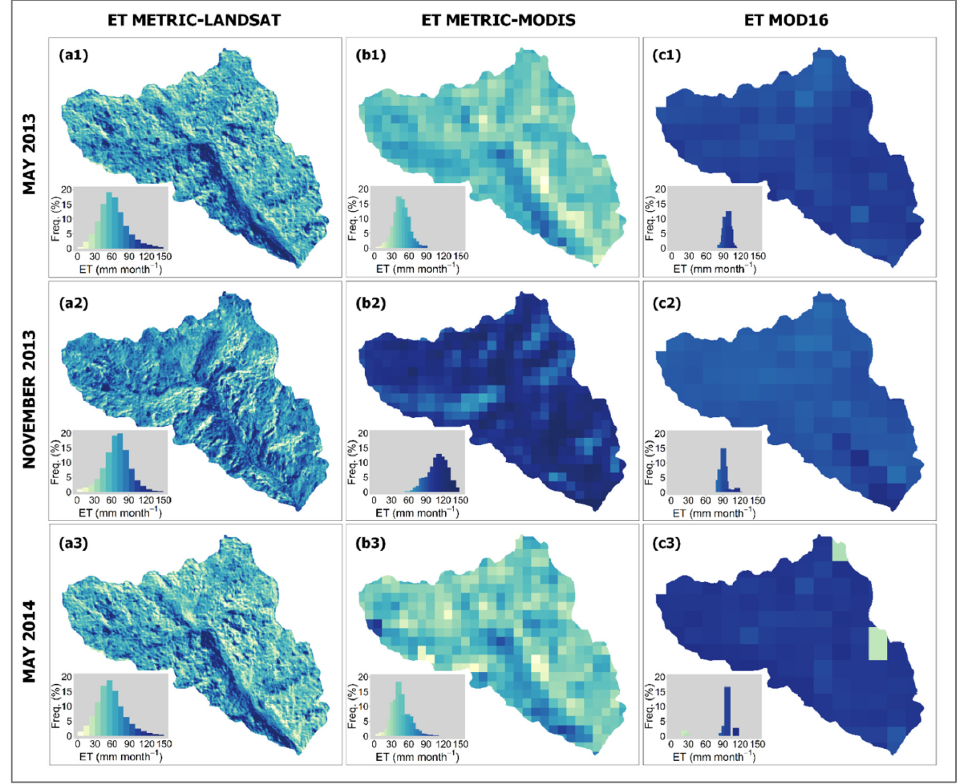
Figure 6. METRIC L , METRIC M and MOD16 ET map comparison for May 2013 ( a1 , b1 , c1 ); November 2013 ( a2 , b2 , c2 ) and May 2014 ( a3 , b3 , c3 ).